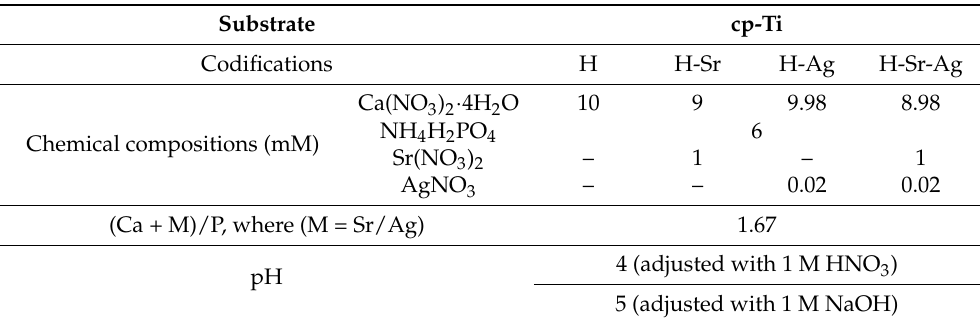
Table 1. Salt concentrations and element concentration ratios of the used electrolytes.